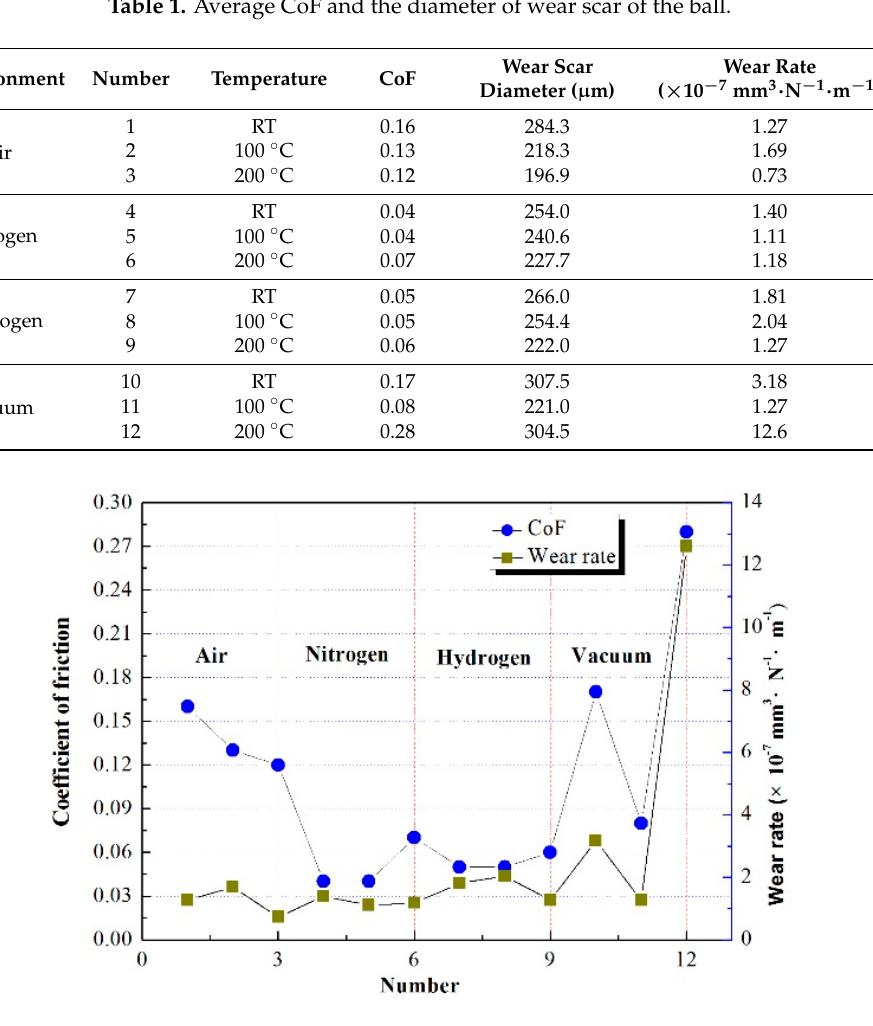
Figure 8. CoF and wear of the friction pair under different temperatures and environments.